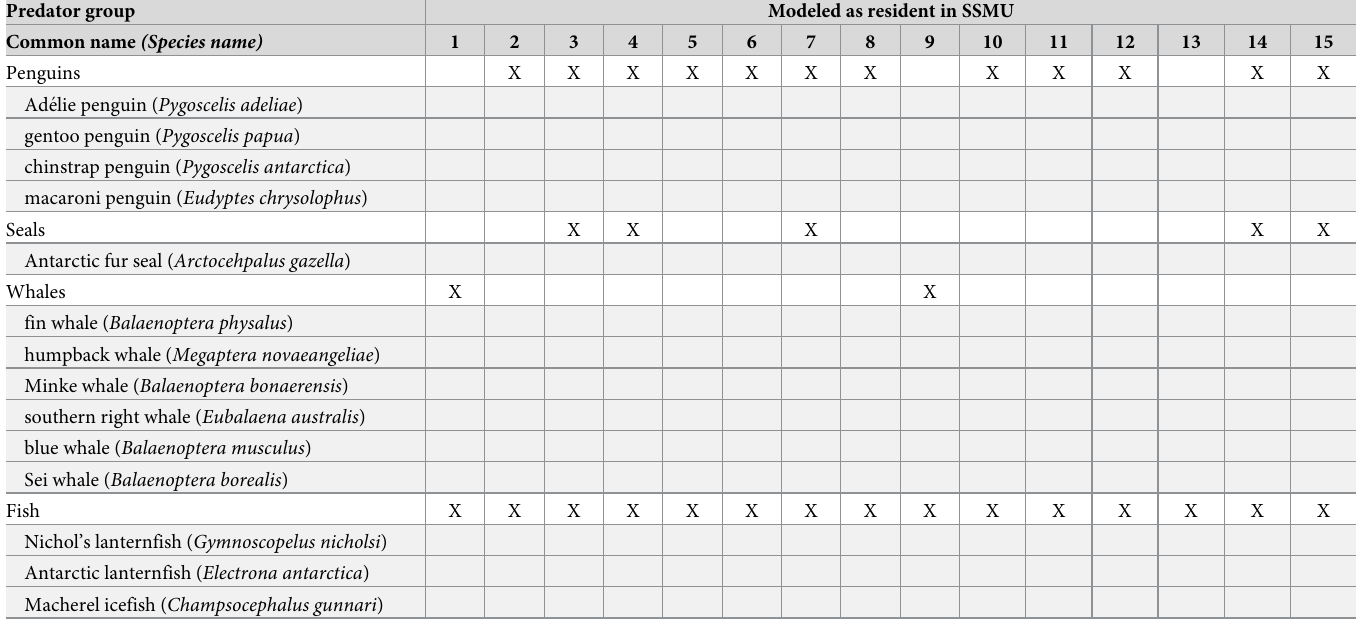
Table adapted from Watters et al.